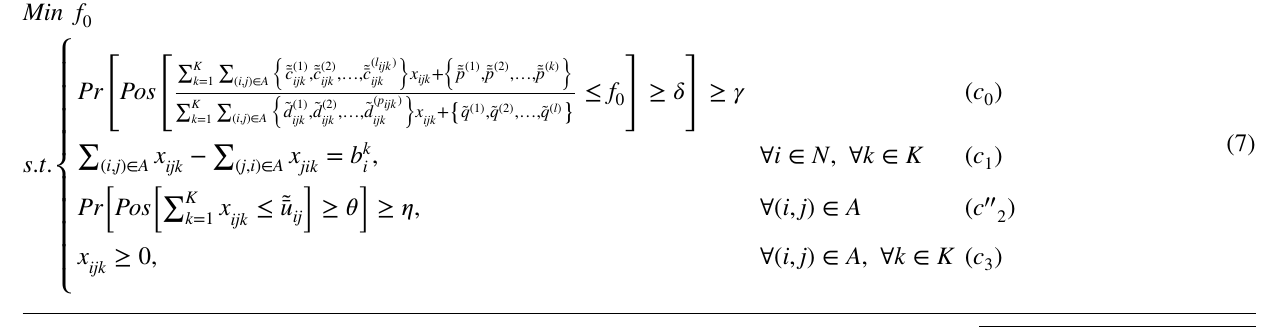
Table 4 Data for